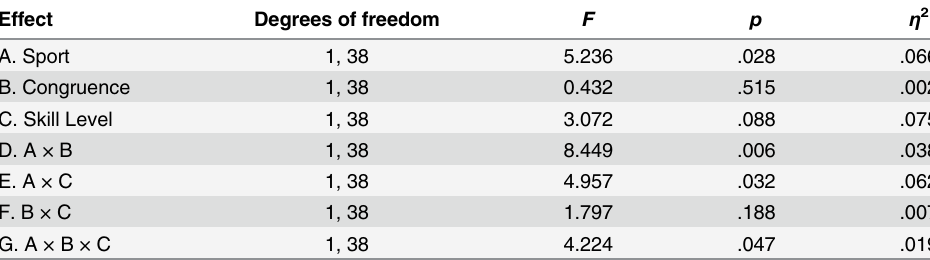
Table 1. Mixed model ANOVA Results for Response Times.